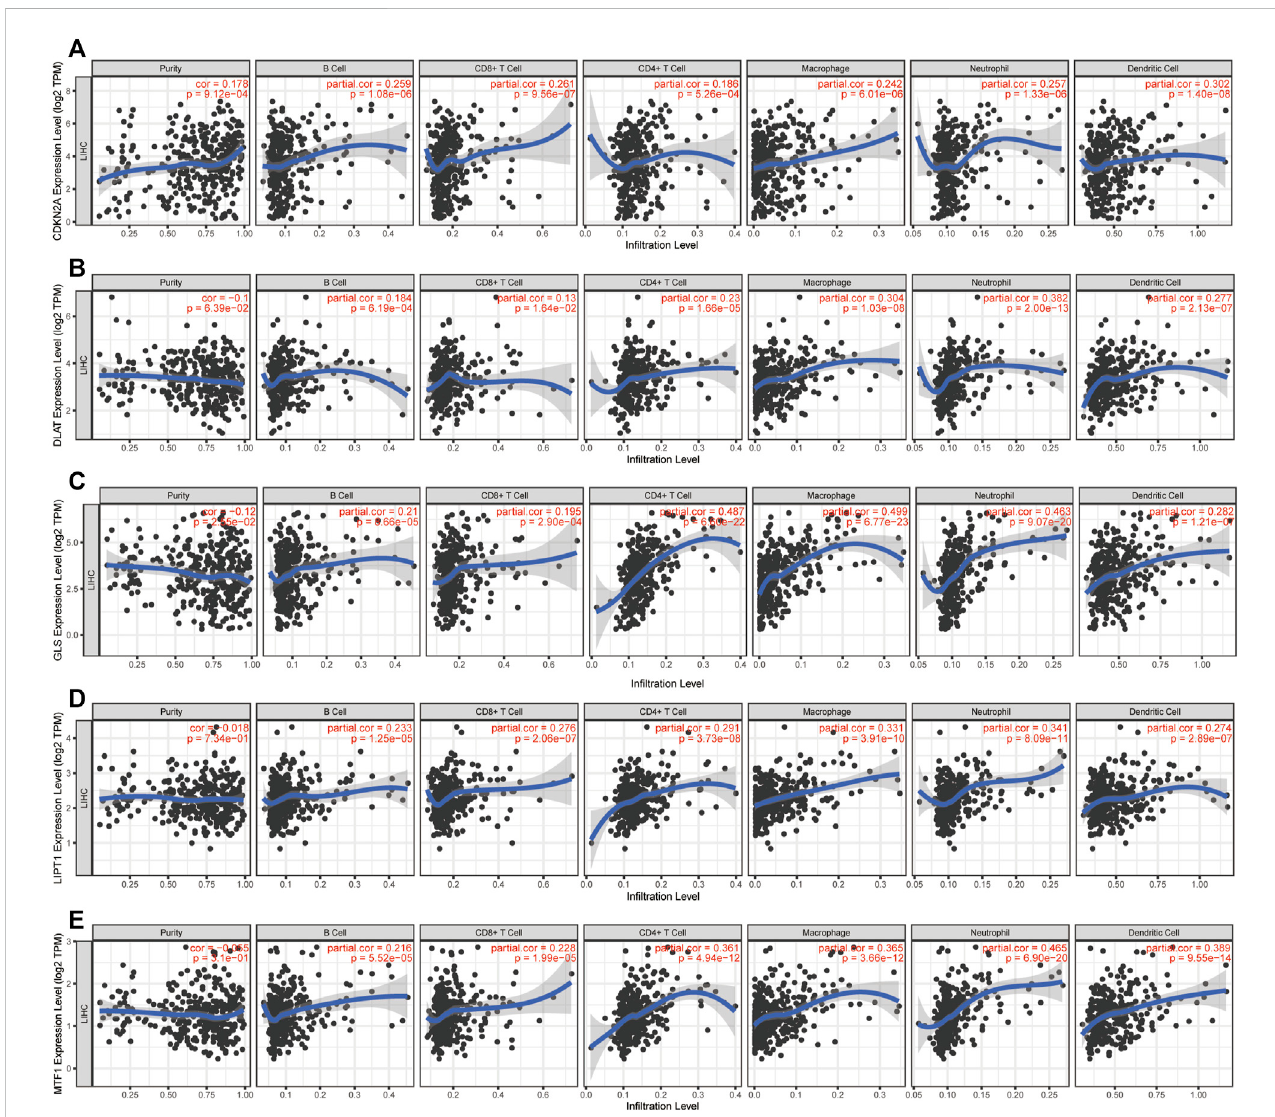
FIGURE 8 Immune in fi ltration analysis of CRGs signatures. Correlation between (A) CDKN2A (B) DLAT (C) GLS (D) LIPT1, and (E) MTF1 expression and immune in fi ltration in HCC from the TIMER database.